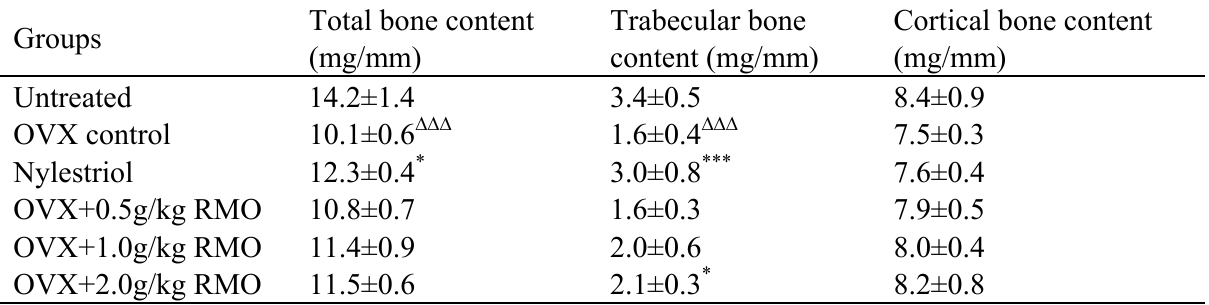
Table 2. Effects of RMO on bone mineral content in OVX rats (n=10).